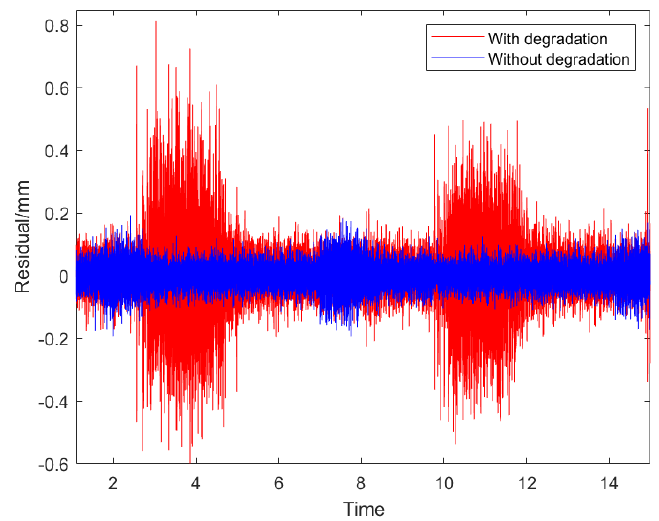
Figure 9. Residual of performance degradation and normal operation.